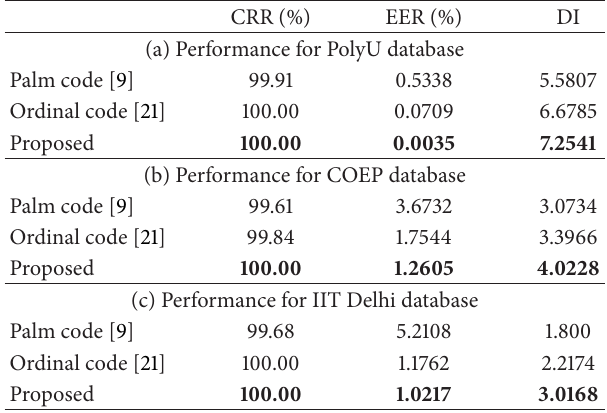
Table1:Performancecomparisonofdifferentpalmprintverification schemes for both local and global combination.